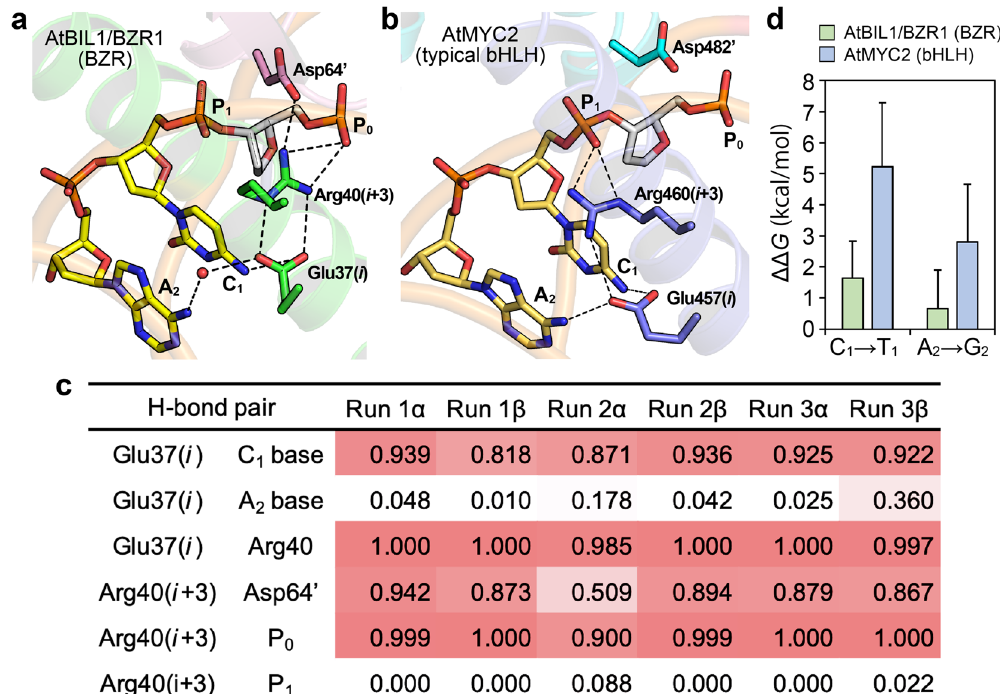
Figure 5. The C 1 A 2 base recognition mode of BZR TFs is distinct from that of typical bHLH TFs. ( a , b ) The essential hydrogen-bonding networks for C 1 A 2 base recognition by the AtBIL1/BZR1-DNA complex ( a ) and AtMYC2-DNA complex ( b ), which are observed in the crystal structures. The residues with or without a prime mark (’) belong to different chains. ‘P N ’ represents a phosphate group at position N. Dashed lines and a red sphere represent hydrogen bonds (including salt bridges) and a water molecule, respectively. ( c ) Ratios of hydrogen bond (H-bond) formation in MD structures of the AtBIL1/BZR1-DNA complex. The results of both chains α and β, which correspond to chains C and D of AtBIL1/BZR1 (PDB ID: 5ZD4), respectively, are shown for 3 independent runs. Colors closer to red indicate a higher ratio. ( d ) The binding free-energy differences (ΔΔ G ) between different nucleobases (C 1 to T 1 and A 2 to G 2 ) in complex with AtBIL1/BZR1 or AtMYC2. Data are the means + standard deviations (SDs, n = 6 independent